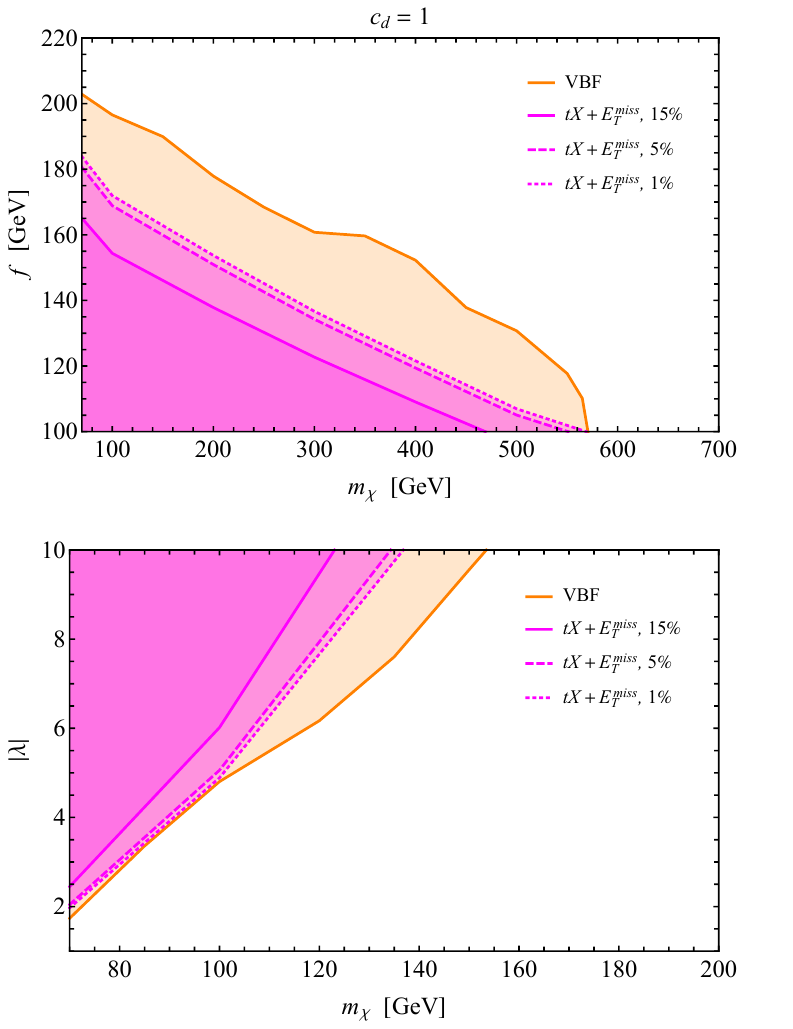
Figure 10 . 95% CL constraints in the m χ – f plane for the derivative Higgs portal model (upper panel) and in the m χ – | λ | plane for the marginal Higgs portal model (lower panel). The orange regions correspond to the 95% CL exclusion limits determined in [25] from a HL-LHC study of off-shell invisible Higgs production in the VBF channel, while the magenta contours represent the results of our tX + E miss search assuming a systematic background uncertainty of 15% (solid curves), T 5% (dashed curves) and 1% (dotted